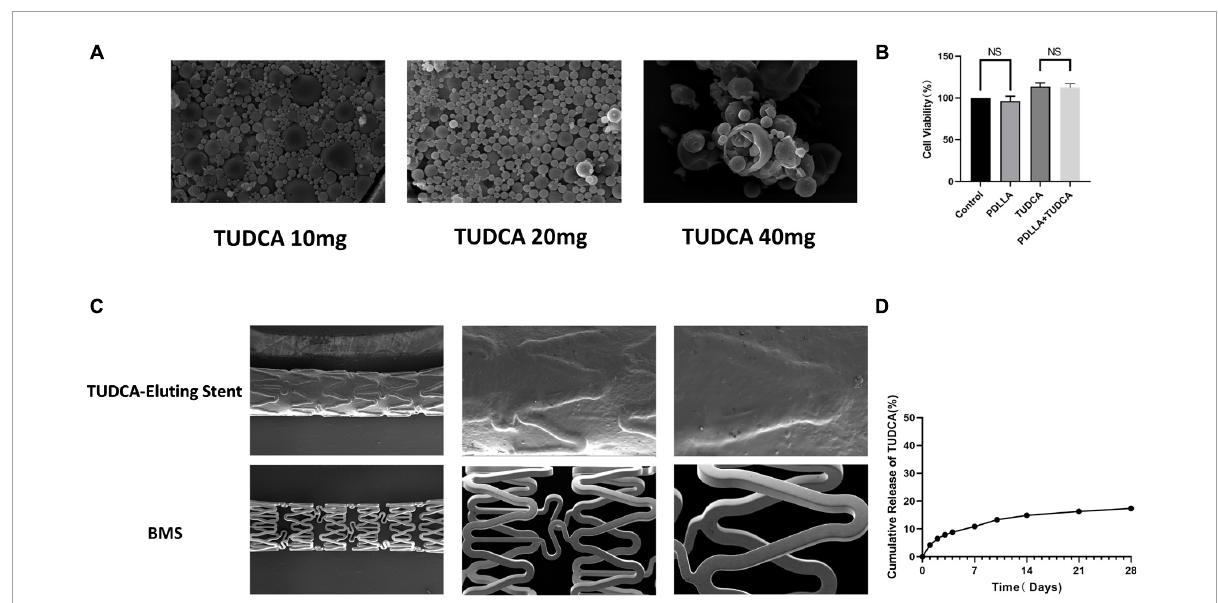
FIGURE1 Preparation and physicochemical properties of poly (D,L-lactic acid) (PDLLA) nanoparticle containing tauroursodeoxycholic acid (TUDCA)-eluting stents. (A) Scanning electron microscope (SEM) of PDLLA nanoparticle containing TUDCA (10/20/40 mg). (B) MTT assay was used to determinate cytotoxicity of the target particles. (NS, not statistically significant, n = 4). (C) SEM of PDLLA nanoparticle containing TUDCA-eluting stents and BMS. (D) The cumulative release rate of TUDCA-loaded nanoparticles was tested in vitro